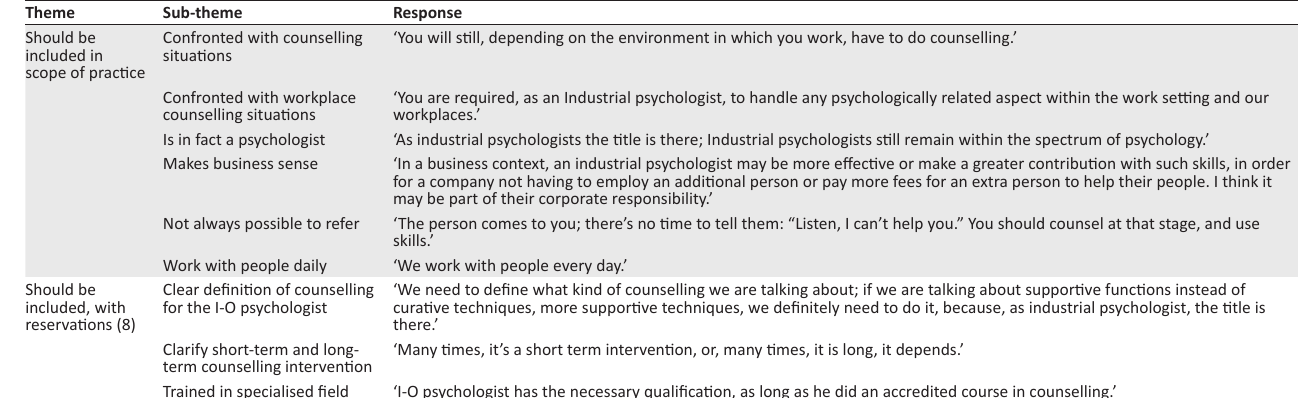
TABLE 3: Inclusion of counselling in the I-O psychologists’ scope of